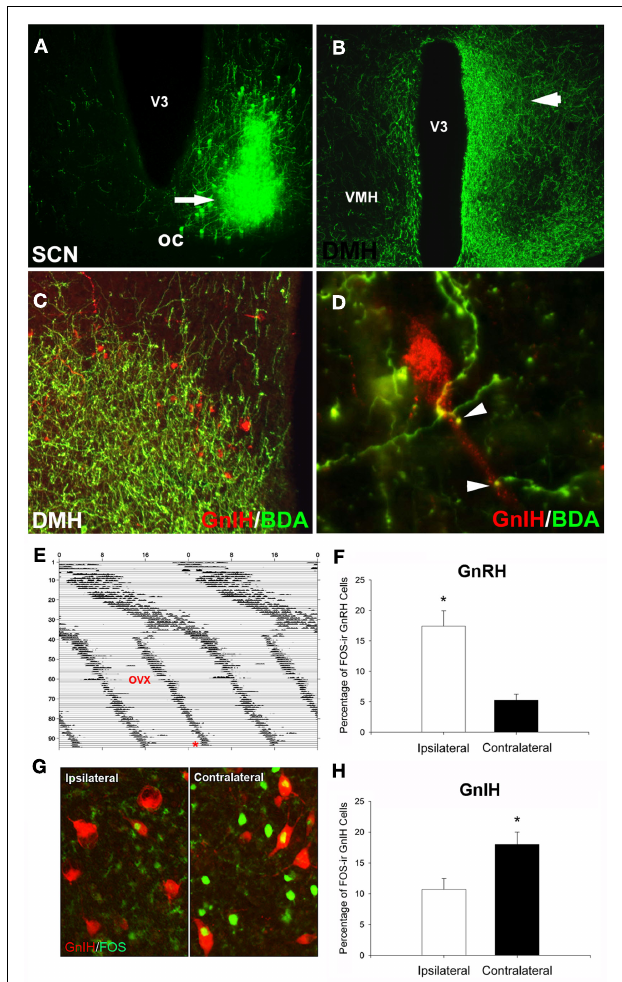
FIGURE 3 | Suprachiasmatic nucleus fibers project to GnIH-ir cells in the DMH. (A) Example injection site from an injection of biotinylated dextran amine (BDA) that filled the ventrolateral aspect of the SCN; (B) low-power photomicrograph indicating terminal fibers from the SCN project to the DMH, principally ipsilaterally. (C,D) Examples of SCN projections in close apposition to GnIH-ir cells in the DMH at the light level [ (C) , low-power; (D) , high power]. (E–H) Lateralization of GnRH and GnIH activation in split hamsters.The pattern of SCN activation is lateralized in animals exhibiting two daily bouts of activity. GnIH cellular activity is lateralized and opposite to that of GnRH, indicating SCN-mediated removal of GnIH inhibition at the time of the LH surge. (E) Actogram of wheel-running activity in estradiol-implanted, ovariectomized (OVX) hamsters kept in constant light conditions (LL) from Day 1 onward (days indicated by y axis, hours by x axis). Split hamsters were killed (*) 1h before the onset of one of the two activity bouts. (G) Photomicrograph of FOS activation in GnIH cells of split hamsters, showing ipsilaterally reduced GnIH activation when SCN and GnRH activation are high. Mean ± SEM) percentage of FOS-ir (F) GnRH and (H) GnIH cells in split hamsters. *Significantly different from the opposite hemisphere’s activational state, P < 0.05. Modified from Gibson et al.